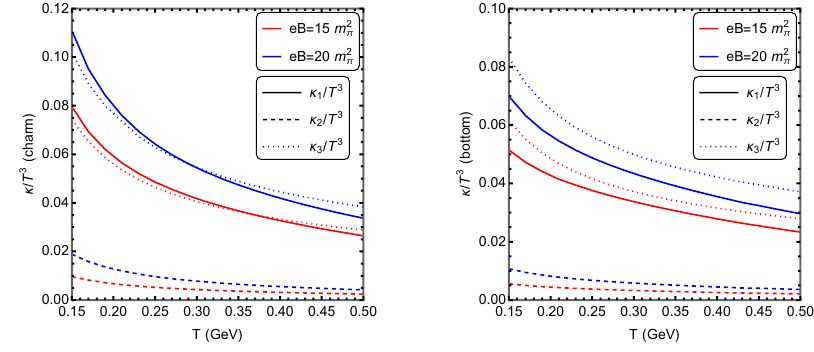
Figure 4. Variation of the scaled charm (left panel) and bottom (right panel) quark momentum di ff usion coe ffi cients (i.e. κ 1 , κ 2 , κ 3 for ⃗v ⊥ ⃗ B represented respectively by solid, dashed and dotted lines) with temperature for two di ff erent values of external magnetic fields, i.e. eB = 15 m 2 bottom quark masses M and HQ momentum p are specified in the